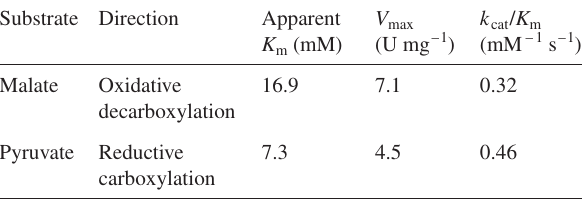
Table 1. Kinetic analysis of recombinant T. kodakaraensis malic en- zyme ( Tk -Mae). All cofactors and co-substrates were present at satu- rating concentrations. For oxidative decarboxylation, NADP + was added at a concentration of 5 mM. For reductive carboxylation, NADPH and NaHCO 3 were added at concentrations of 0.05 and 12.5 mM, respectively. For both reactions, Mn 2+ was present at a con- centration of 5 mM. Abbreviations: K m = Michaelis constant; V max = maximum velocity; and k cat / K m = catalytic